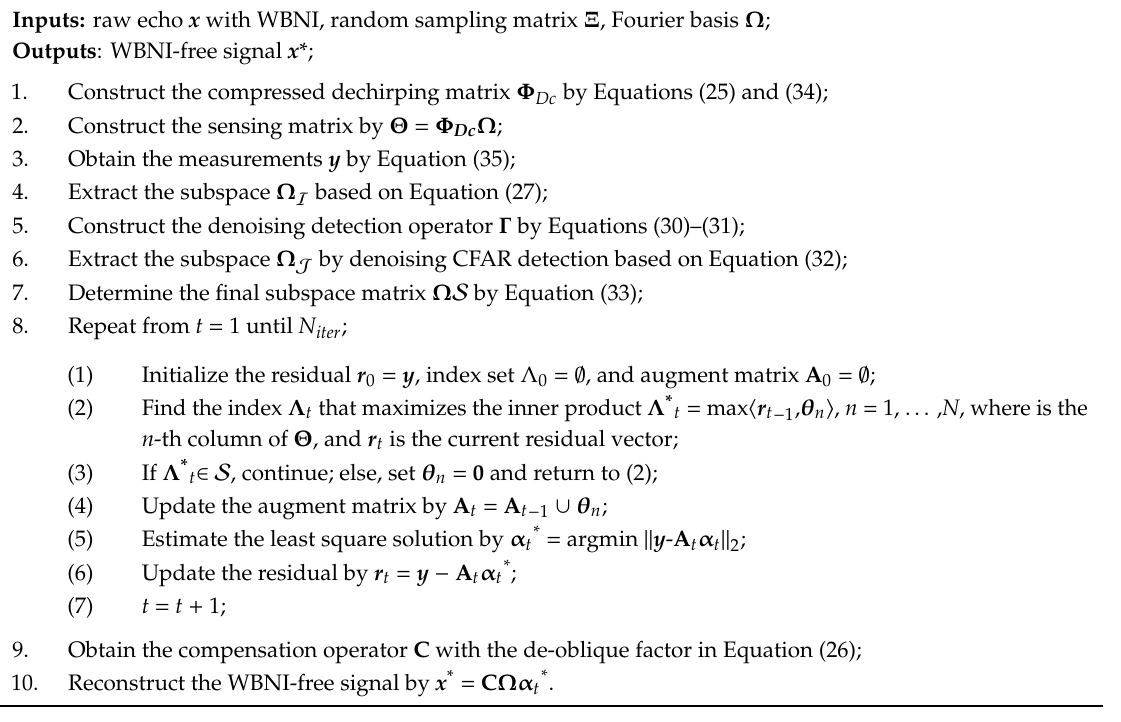
Algorithm 1 Dechirping and double subspace extraction